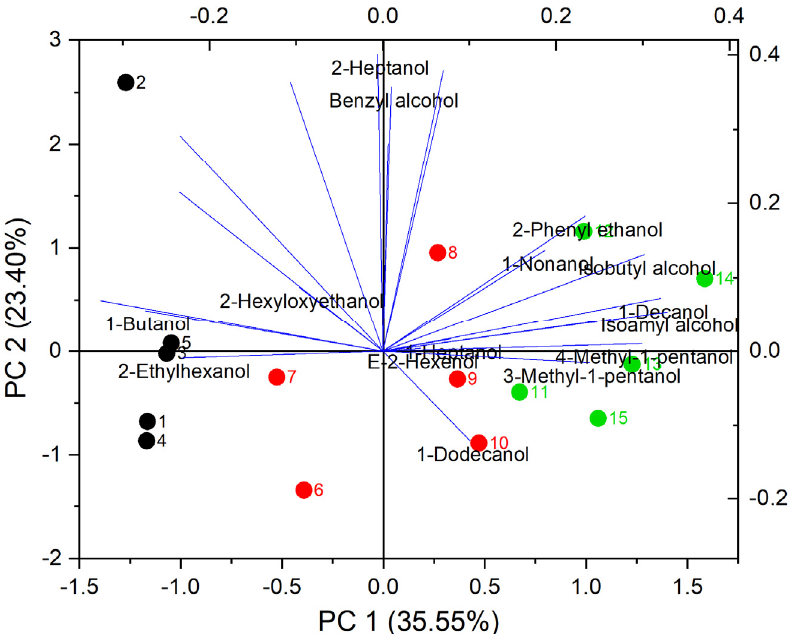
Figure 5. PCA for higher alcohols in Cabernet Sauvignon wines produced by supplemented fermentations with different nitrogen sources. Samples 1 to 5 are DAP (BLACK), 5 to 10 are LDH (red), and 11 to 15 are HDH (green).